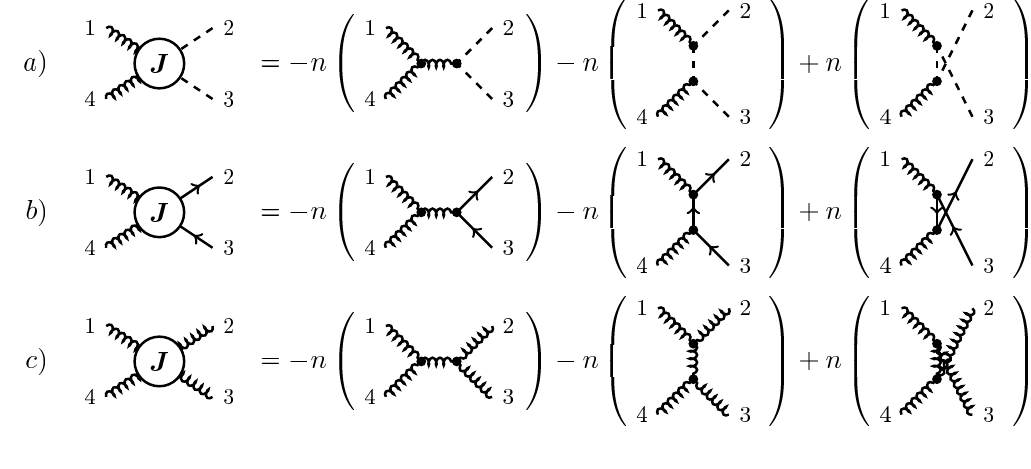
Figure 2 . Jacobi combination for gg